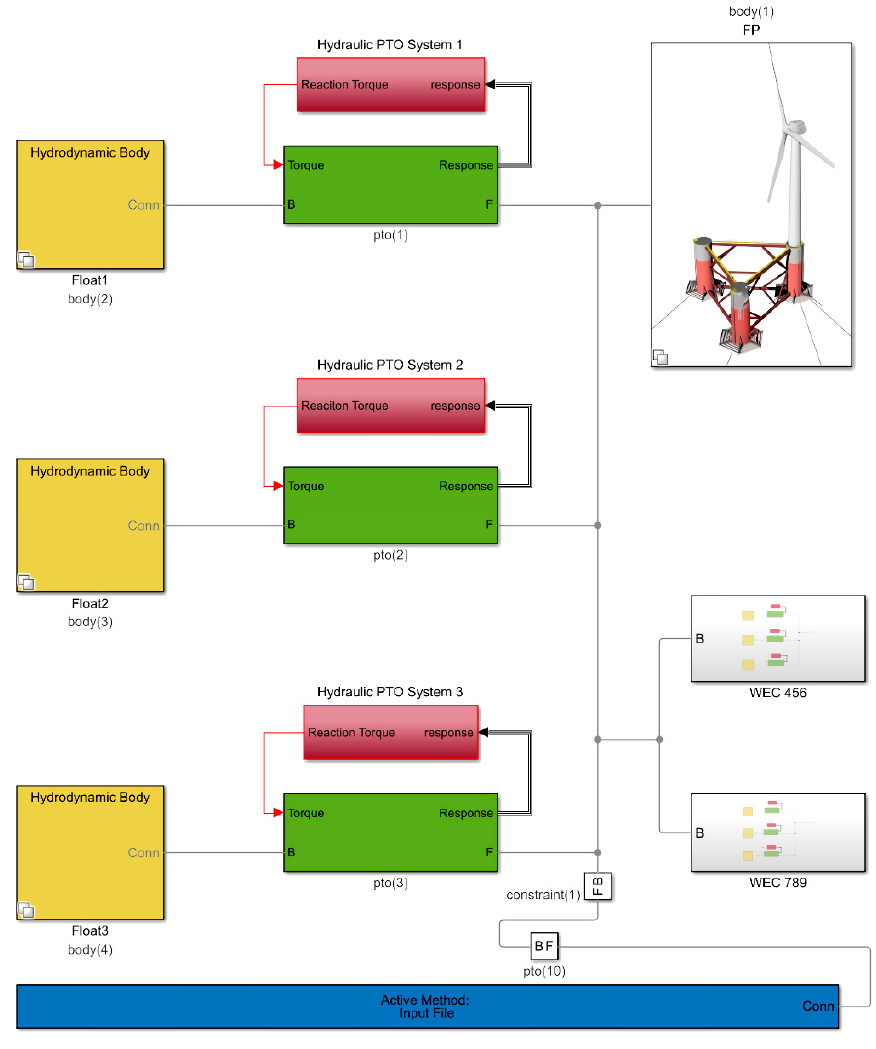
Figure 3. An overall diagram of the numerical simulation framework in MATLAB/Simulink.